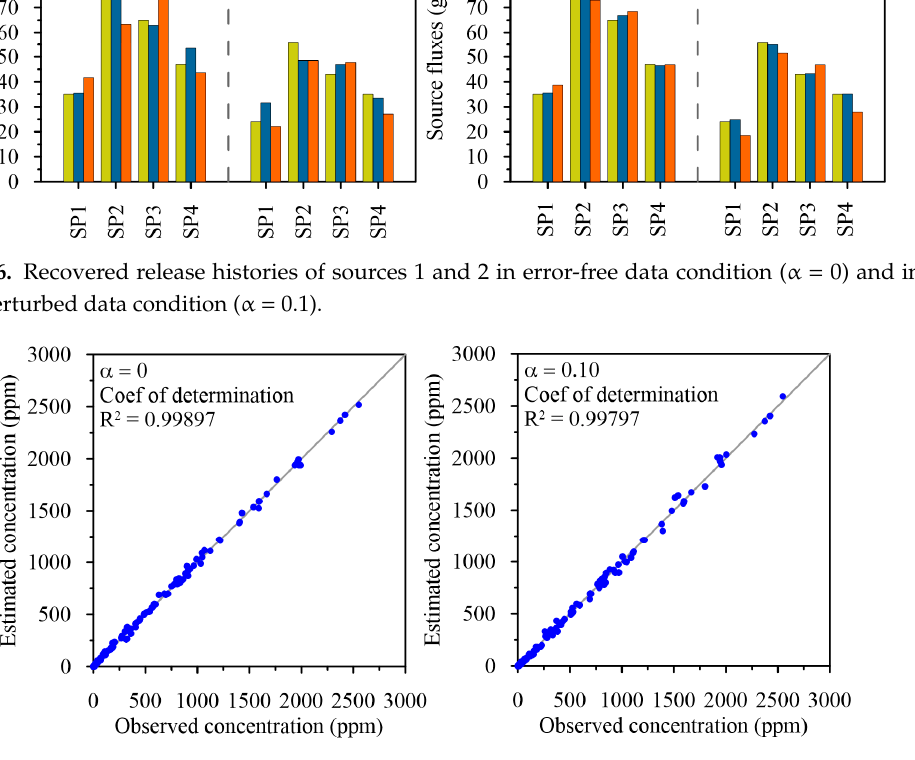
Figure 7. Estimated vs. observed concentration in error-free data condition ( α = 0) and in error-perturbed data condition ( α = 0.10).